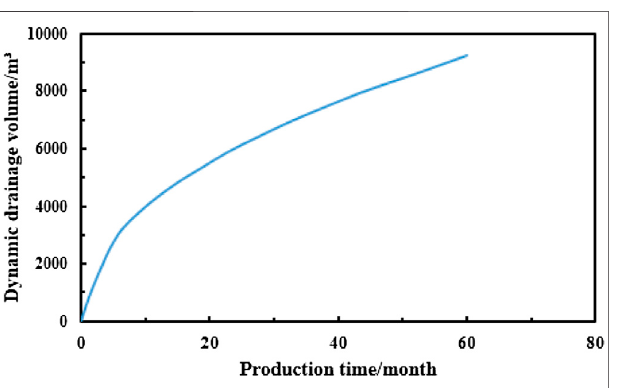
FIGURE 5 | Flow chart of determining refracturing timing by dynamic drainage volume